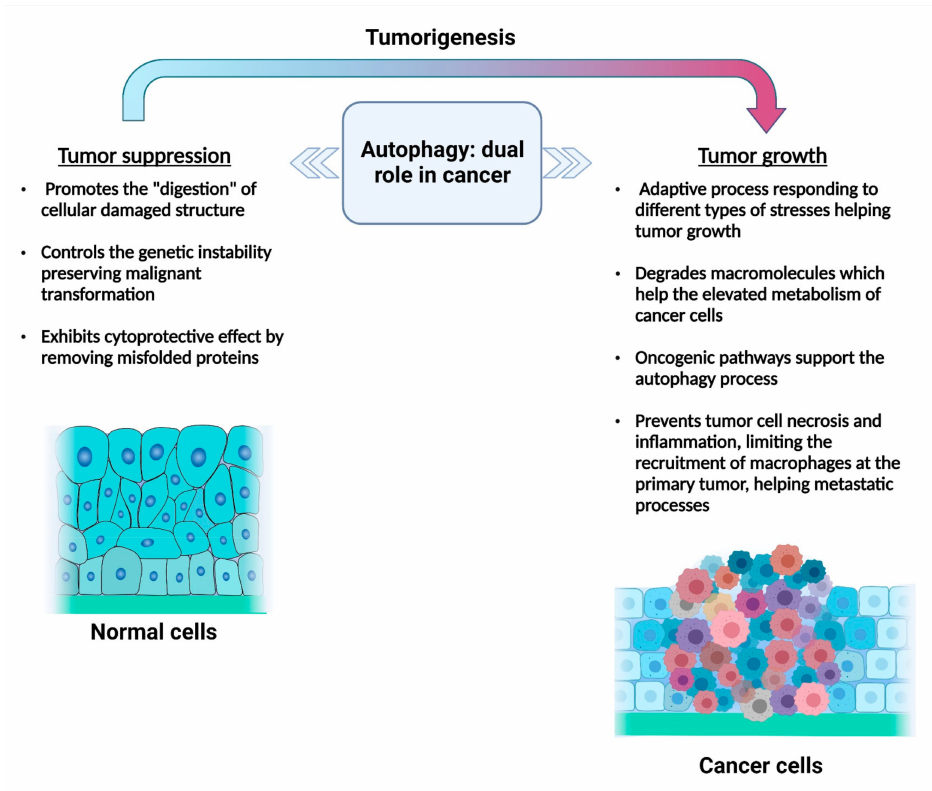
Figure 2. Dual function of autophagy in cancer. The dualistic function of autophagy in cancer. Autophagy in the initial stages of cancer promotes tumor suppression by digesting cellular damaged structures. In contrast, in the late stages of cancer, autophagy sustains cancer cell growth by support- ing elevated metabolism and by limiting the recruitment of macrophages. The figure was created with BioRender.com. Licensing Right GD24OB603C, 21 November